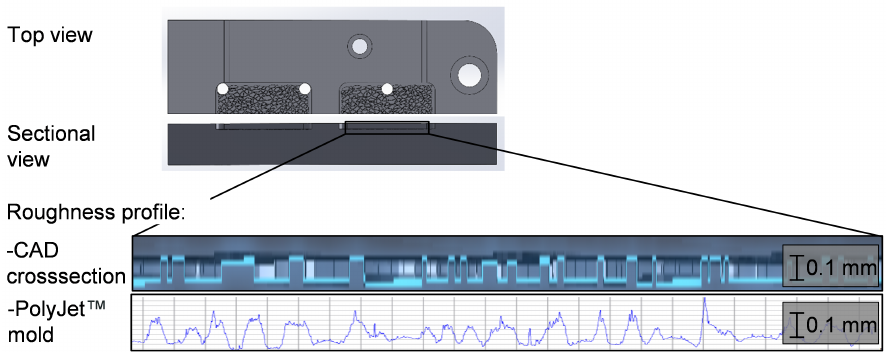
Figure 4. Exemplary comparison of the roughness profiles of CAD and PolyJet™ mold in cavity